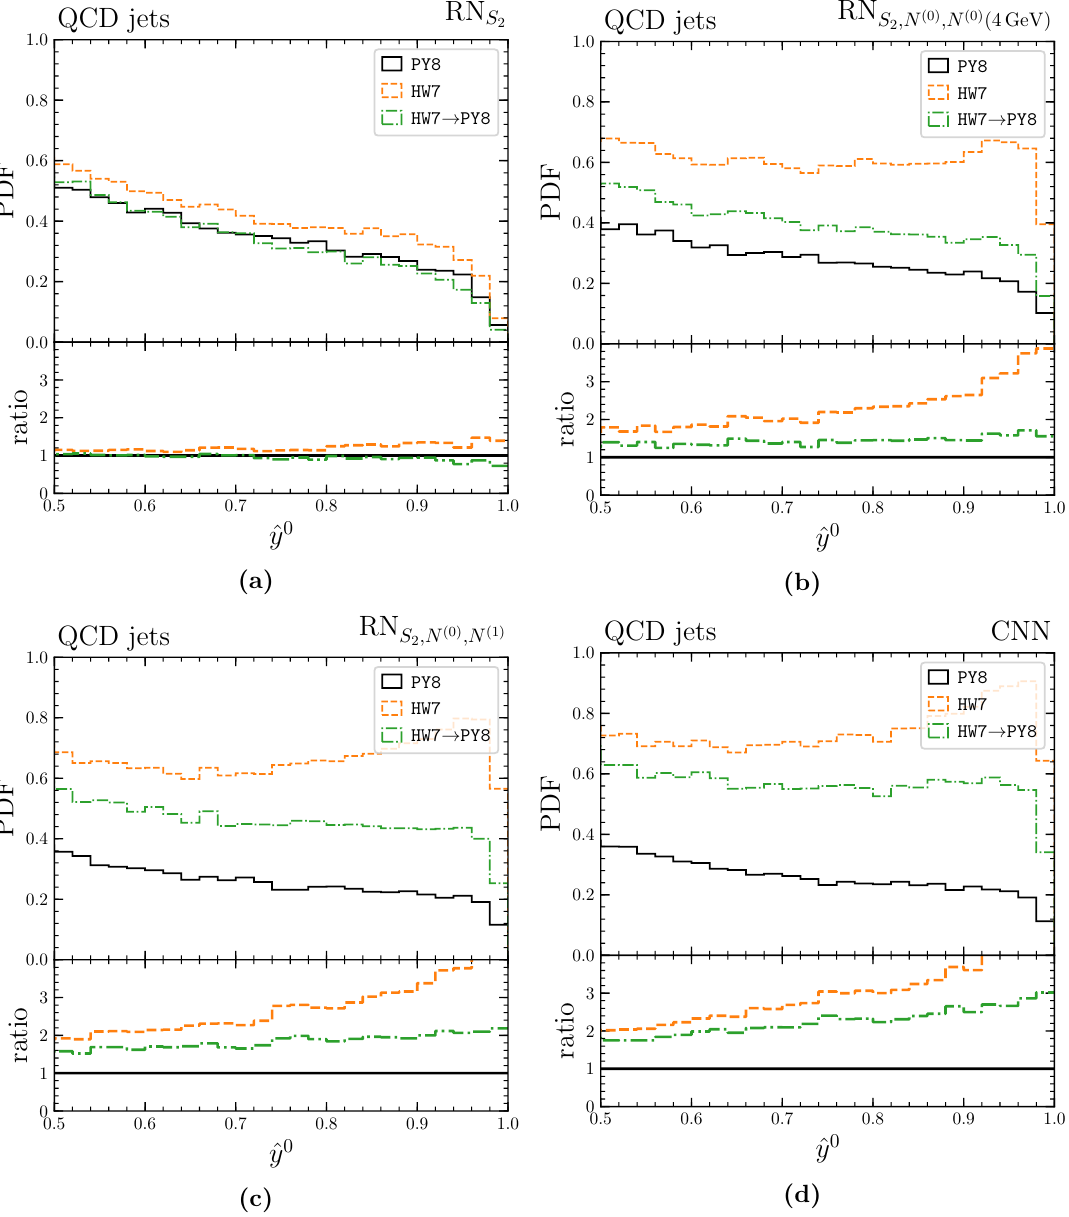
Figure 21. The ^ y 0 distributions of PY8 and HW7 test samples for the model trained on the PY8 events. The neural networks used in the plots are (a) RN S RN , and (d) CNN. S 2 ;N (0) ;N (1)